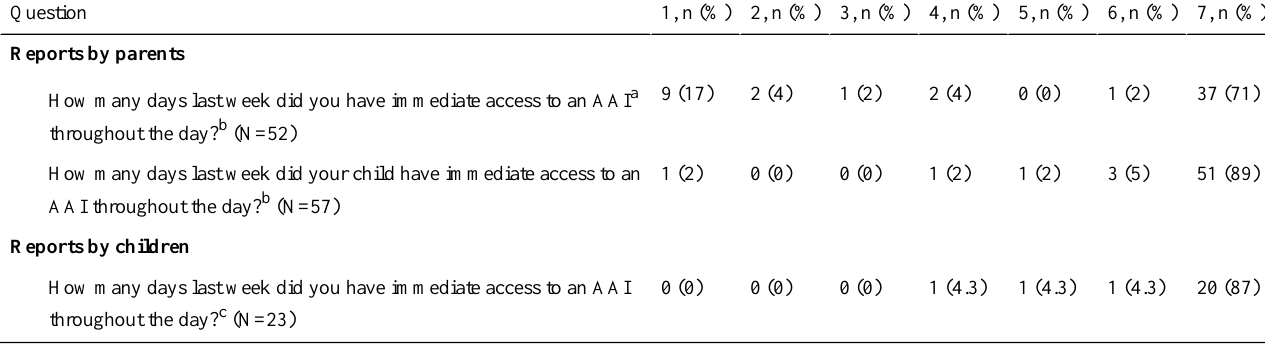
Table 7. Third question about